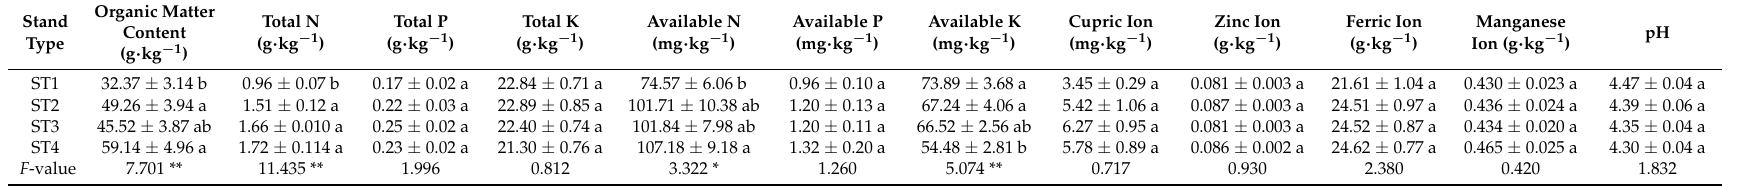
Table 5. Chemical properties of soil in different stand types of JRP pure